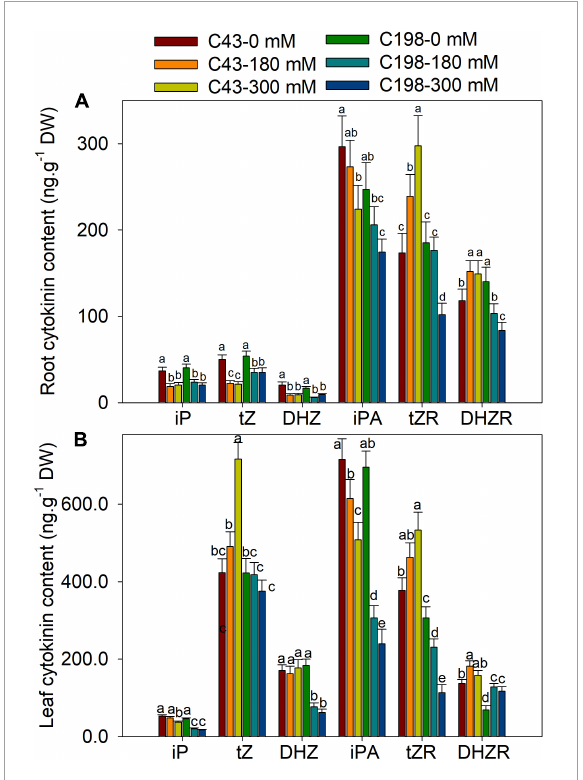
FIGURE5 Effects of salt stress on root (A) and leaf (B) cytokinin content in the two genotypes of bermudagrass (C43, tolerant; C198, sensitive). Bars marked by the same letters are not significant at P < 0.05 (Tukey’s test) for the comparison of different salt concentrations in two genotypes. Data represent the mean ± SD of four independent biological replicates.